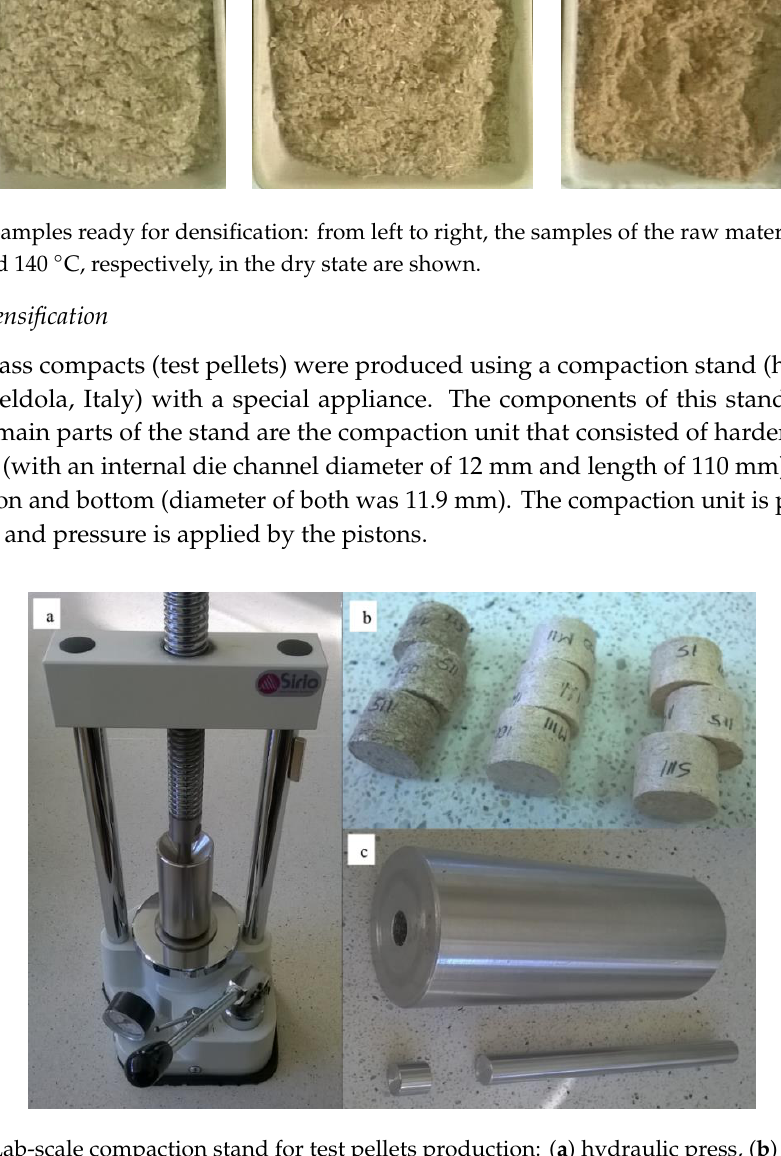
Figure 4. Lab-scale compaction stand for test pellets production: ( a ) hydraulic press, ( b ) samples of compacts, and ( c ) die, piston and bottom.